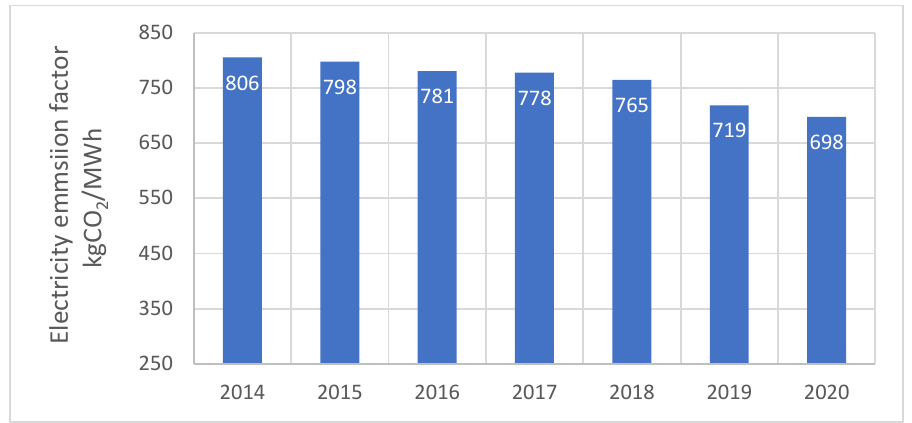
Figure 3. Emission factors per 1 MWh of electricity produced at the end user in Poland (2014 – 2020) (kg CO 2 /MWh) (own study based on National Centre for Emissions Management annual reports).